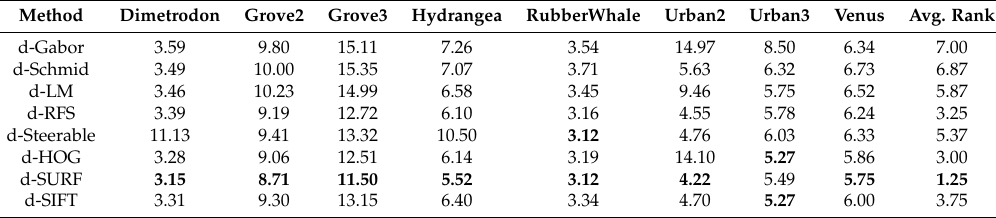
Table 4. Interpolation Error (IE) comparison for training images of the Middlebury dataset.